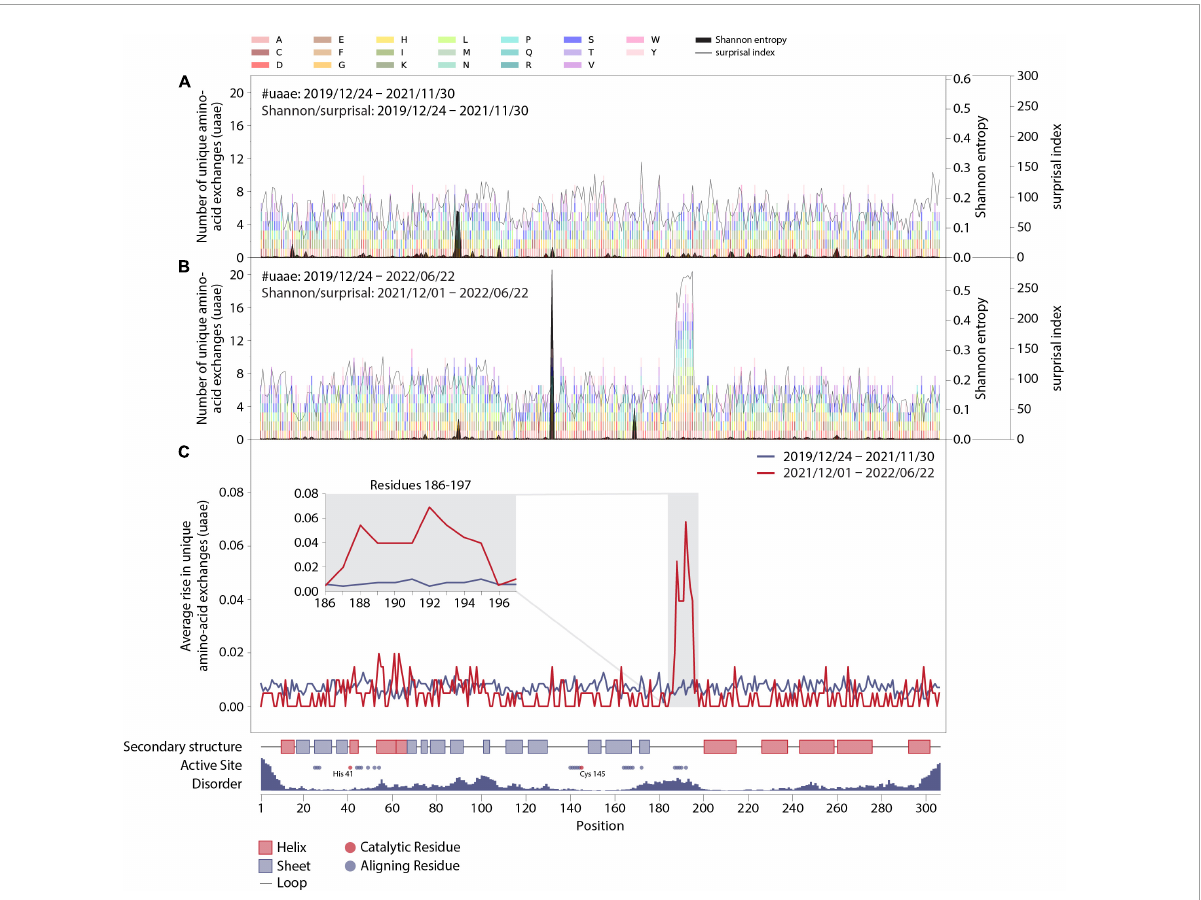
FIGURE2 Mutation dynamics in the M pro amino-acid sequence. (A) Final distribution of unique amino-acid exchanges for every position within the wild-type M pro sequence including all sequences with a corresponding collection date before December 2021 (transparent multi-colored bars). Associated surprisal indices and Shannon entropies are superimposed in light and dark gray, respectively. (B) As in panel (A) , including all sequences with corresponding collection dates up until 22 June 2022, with associated surprisal indices and Shannon entropies, which were calculated from sequences collected from 1 December 2021 to 22 June 2022. (C) Average rise in unique amino-acid exchanges along the protein sequence including sequences collected before (blue) and starting from (red) 1 December 2021. Insert: Zoom in on positions R188-G195 and adjacent residues V186, D187, T196, and D197. The sequence position, complemented by structural properties partly obtained from PDB entry 7SI9 (43), is displayed on the x